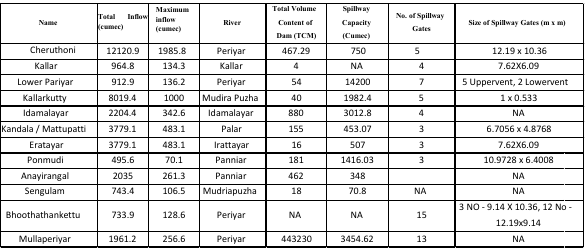
**Idduki and Cheruthoni Dam both come under same sub basin hence in our study combined inflow of both is found.